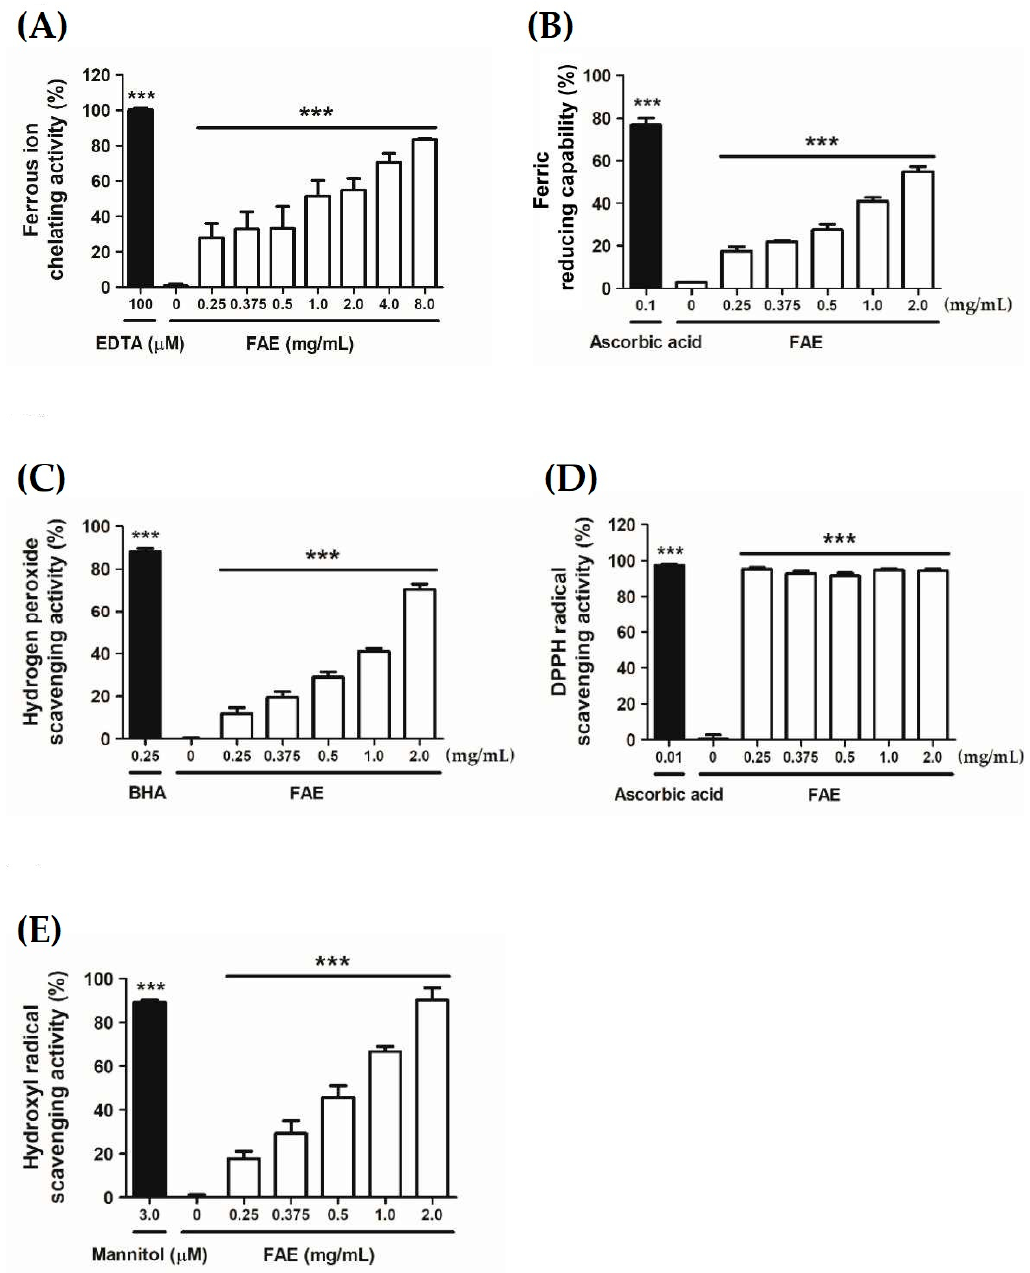
Figure 2. The antioxidant capacity of Ficus awkeotsang Makino extract (FAE). ( A ) Ferrous chelating activity, ( B ) ferric-reducing antioxidant capability, ( C ) DPPH radical scavenging activity, ( D ) H 2 O 2 scavenging activity, and ( E ) hydroxyl radical scavenging activity. Statistical significance of the differences between negative control (0 mg/mL FAE treatments), positive standard (black bar), and other treatments were determined using Tukey’s HSD test. *** p < 0.001; n = 3; all error bars represent the standard deviation of the mean.